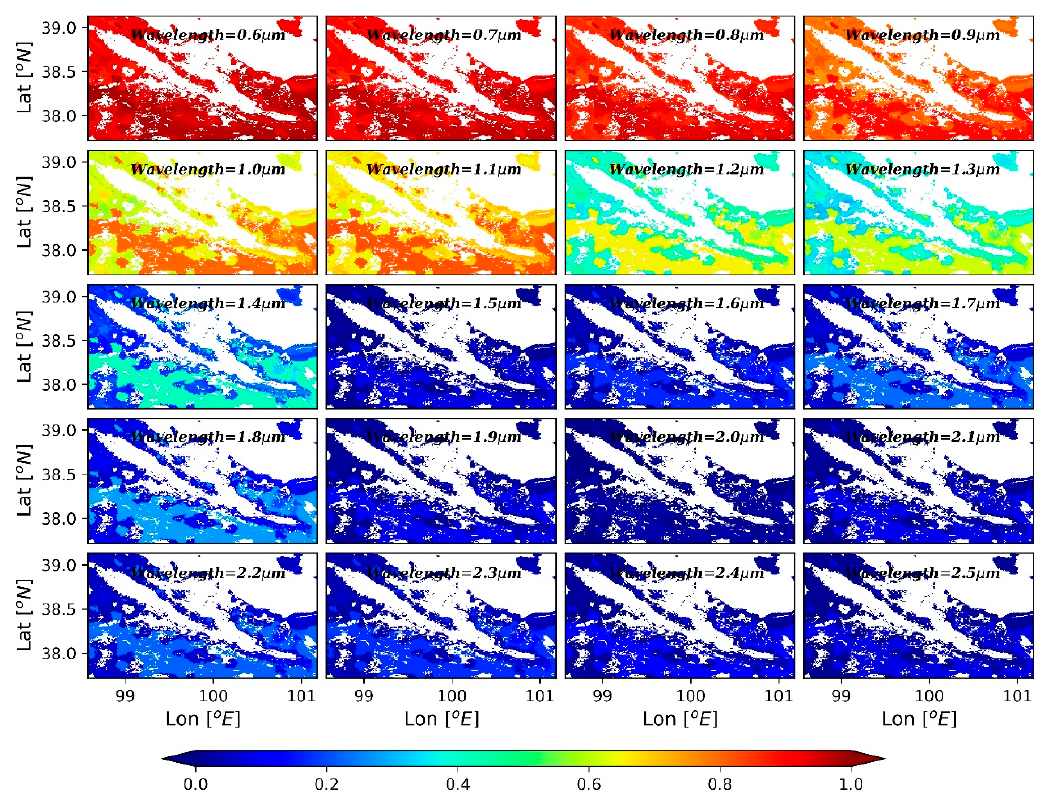
Figure 6. Snow spectral albedo simulated by the integrated model (wavelength = 0.6~2.5 µ m; wavelength interval = 0.1 µ m).